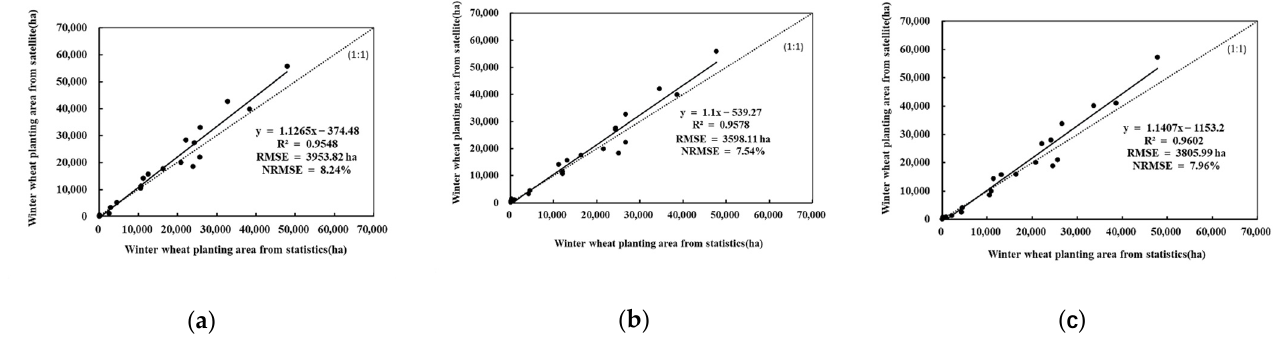
Figure 4. ( a ) The comparative results of the statistical and extracted areas of winter wheat in Shijiazhuang in 2017. ( b ) The comparative results of the statistical and extracted areas of winter wheat in Shijiazhuang in 2018. ( c ) The comparative results of the statistical and extracted areas of winter wheat in Shijiazhuang in 2019.